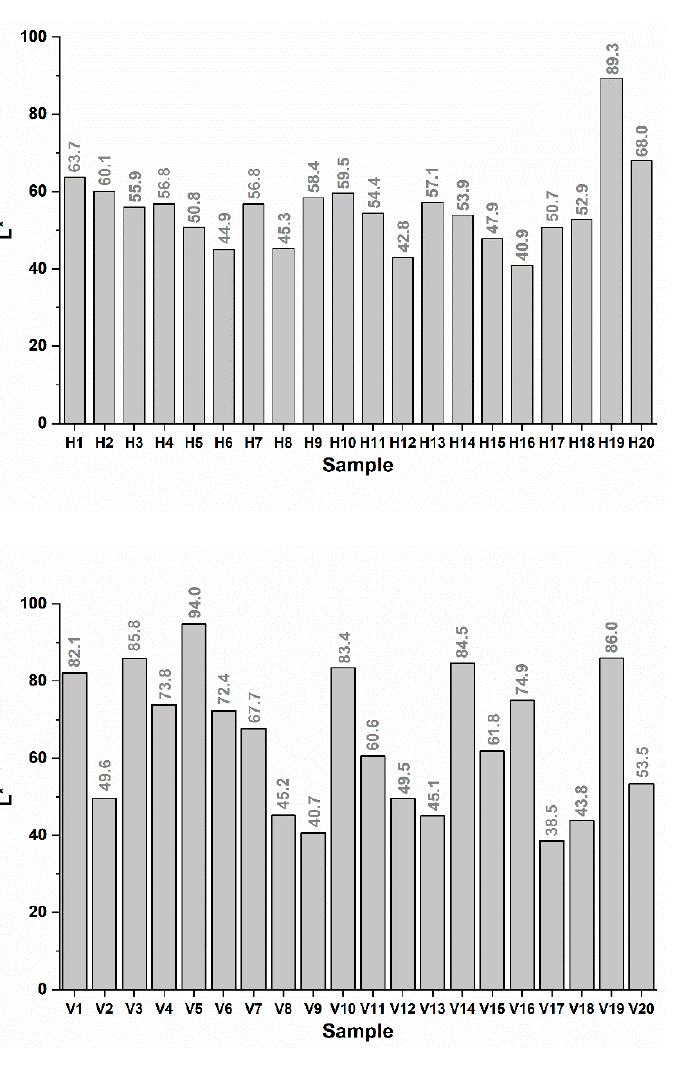
Figure 5. Color coordinate L* of the materials analyzed in situ. Top : horizontal surface finishes. Bottom : vertical surface finishes.